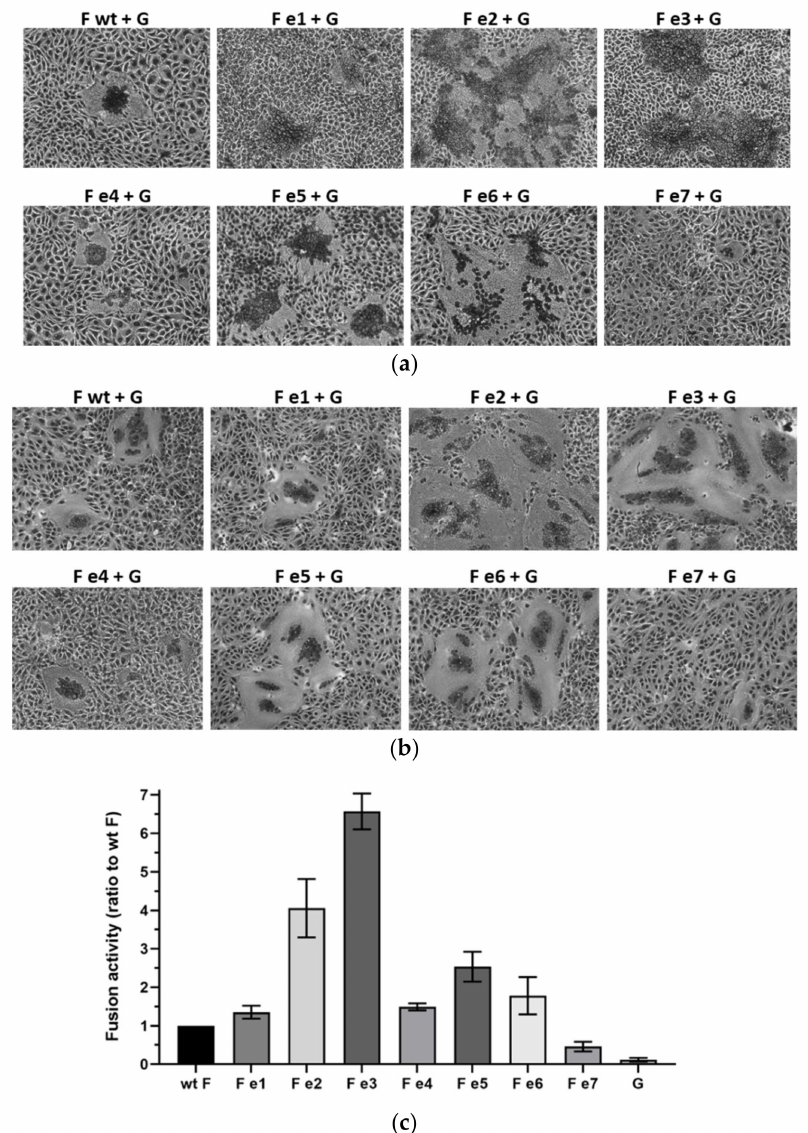
Figure 6. E ff ect of cytoplasmic tail mutations on CedV glycoprotein-mediated fusion activity. Syncytium formation in ( a ) MDCK-2 and ( b ) Vero76 cells co-expressing CedV F and G proteins were visualized by Giemsa staining at 48 h p.t. Magnification, × 20. n = 3; wt: wild-type ( c ) Quantitative reporter gene assay. Vero76 cells were co-transfected with plasmids encoding for the CedV glycoproteins F and G as well as a plasmid containing the luciferase gene under the control of a T7 promoter (pCITE Renilla). At 24 h p.t., Vero76 cells expressing the T7 polymerase were layered on the glycoprotein-expressing cells and incubated for 3 h at 37 ◦ C. Then, cells were lysed, and luciferase activity measured using a luminometer. Samples were tested in duplicates in three independent experiments. Reporter activity measured for the parental CedV F protein (wt F) co-transfected with CedV G protein was set to 1 serving as a reference point for fusion activity. Bars represent the fusion activities of the di ff erent (mutant) CedV F proteins in relation to the fusion activity of the parental protein and include the standard error of the mean (SEM). Background activity of the luciferase reporter was assessed with cells transfected with pCAGGS CedV G and pCITE Renilla only, layered with T7 polymerase expressing cells. n =